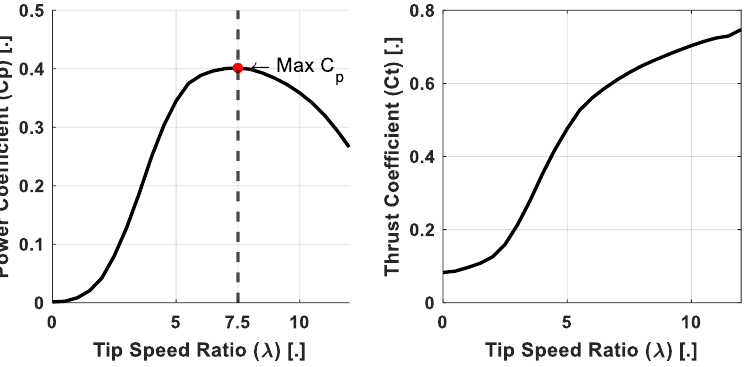
Figure 3. Wind turbine blade aerodynamic analysis.